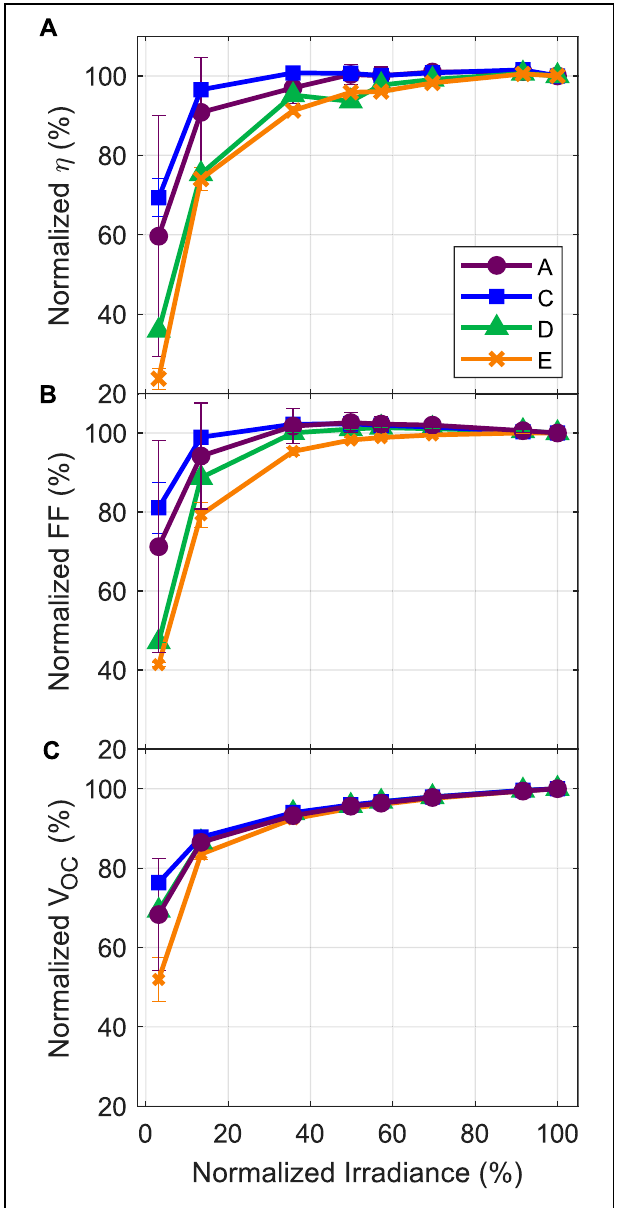
FIGURE 1 | Normalized irradiance dependence of the primary IV parameters: (A) efficiency, (B) fill factor, (C) open-circuit voltage. For each cell type, mean values (symbols) and standard deviations (error bars) are